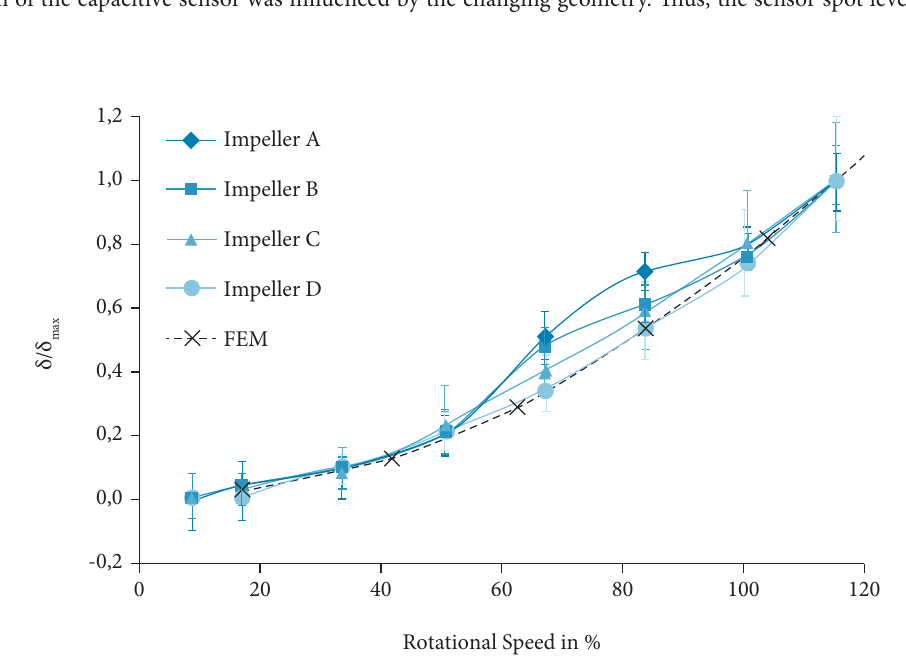
Figure 13. Normalized deformation over speed for four impellers during spin tests compared to FEM